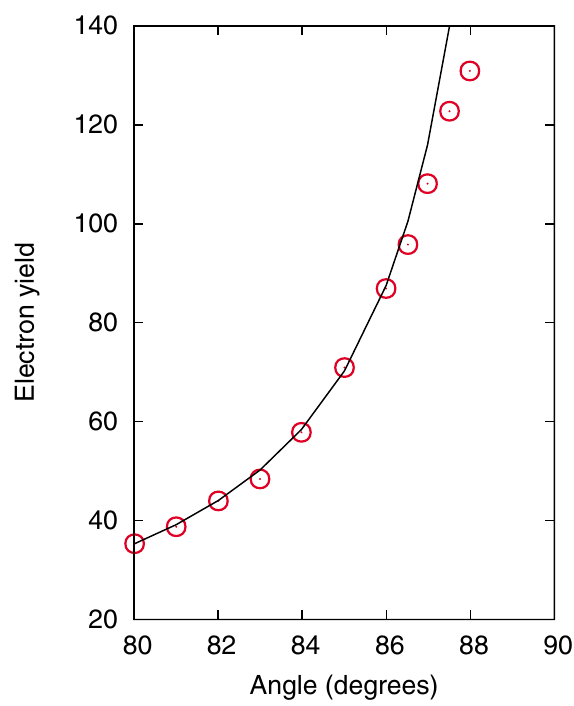
FIG. 1. (Color) Measured electron yield as a function of angle of incidence of the ion measured from the surface normal for 1.0 MeV potassium hitting stainless steel. The red circles are the electron yield as measured by researchers at LBL. The solid line is the prediction of a geometric theory discussed in Sec. II. One goal of this work is to better understand the deviation of the measured yield from the theory at grazing